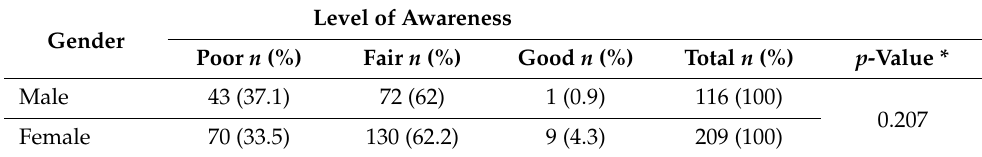
Table 5. The relationship between “awareness levels of amblyopia among parents” and “having a child with an eye disease”.